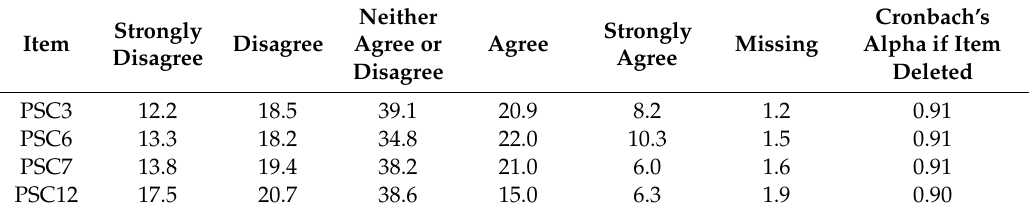
Table A6. Distribution of item responses in percentages and Cronbach’s alpha if the item was deleted from the scale (managerial and non-managerial